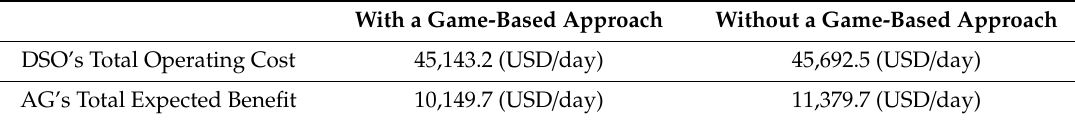
Table 11. Comparison between two case